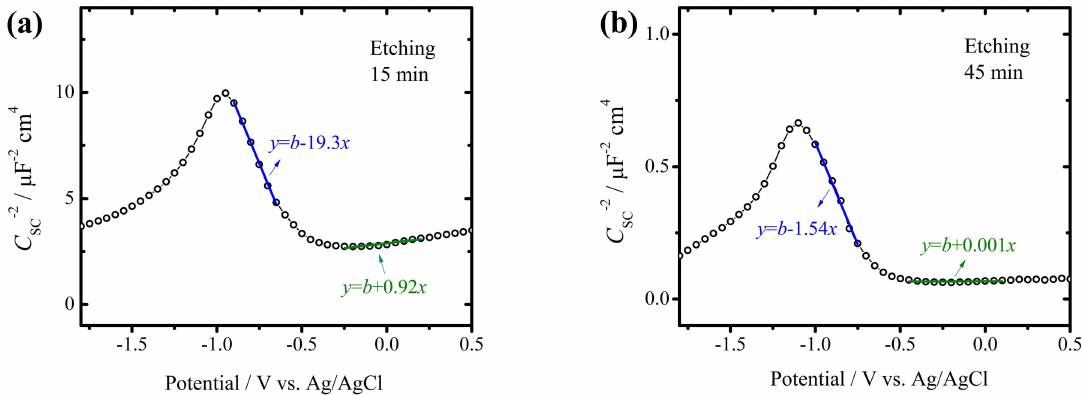
Figure 5. Mott-Schottky plots of the etched AAO layers. The samples of barrier layer have been 400 ◦ C annealed for 1 h are then etched in sulfuric acid for ( a ) 15 and ( b ) 45 min. Note the positive slope flattens as etching time